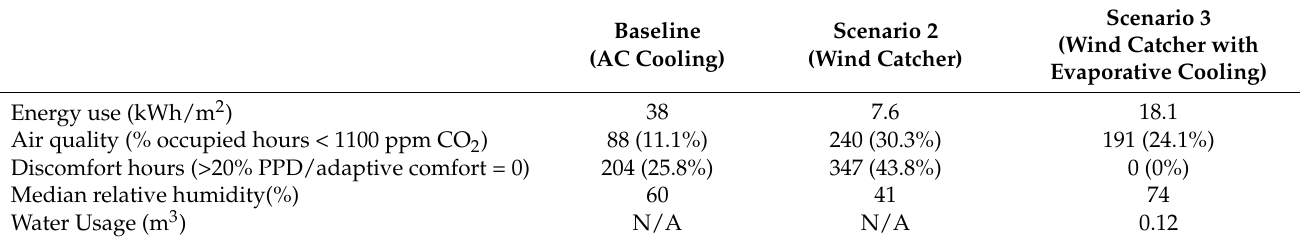
Table 3. Results summary table comparing the different scenarios for the timeframe April to